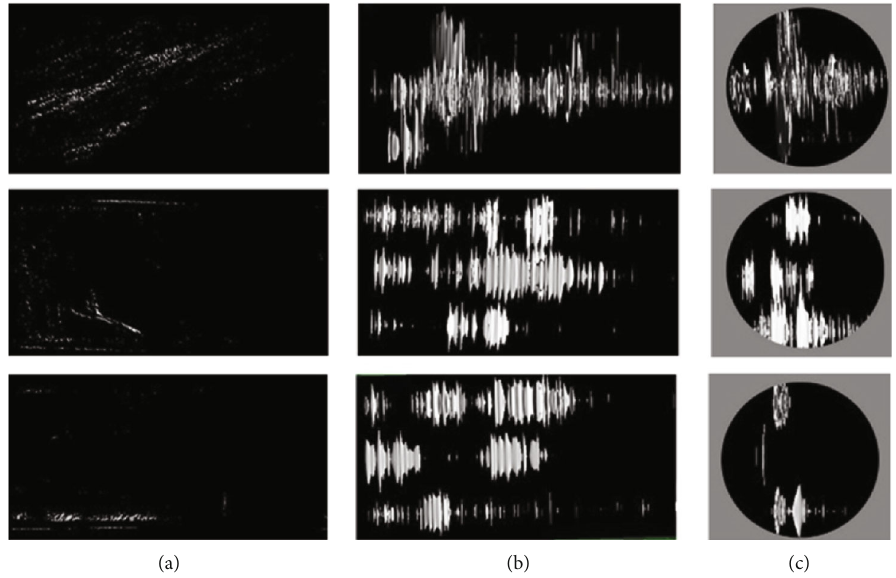
Figure 4: NMR reconstruction of coal samples: (a) main view, (b) top view, and (c) side view. Table 3: Dimension and crack ratio of coal sample. Sample no.